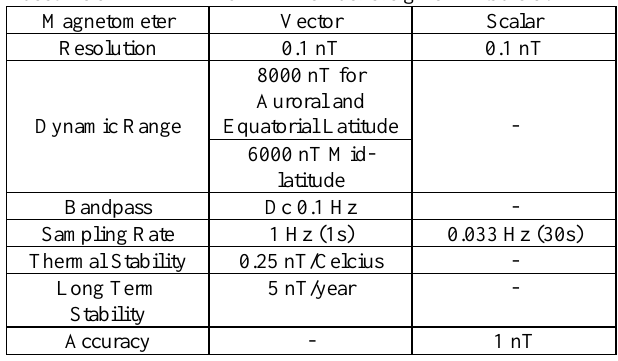
Table 3 . Minimum magnetometer standards determined by